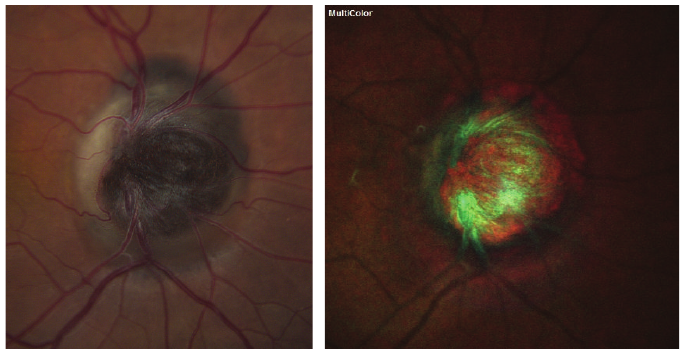
Figure 3: Optic disk photograph and multicolor showing a deeply pigmented lesion in the optic nerve head with adjacent choroid and retinal